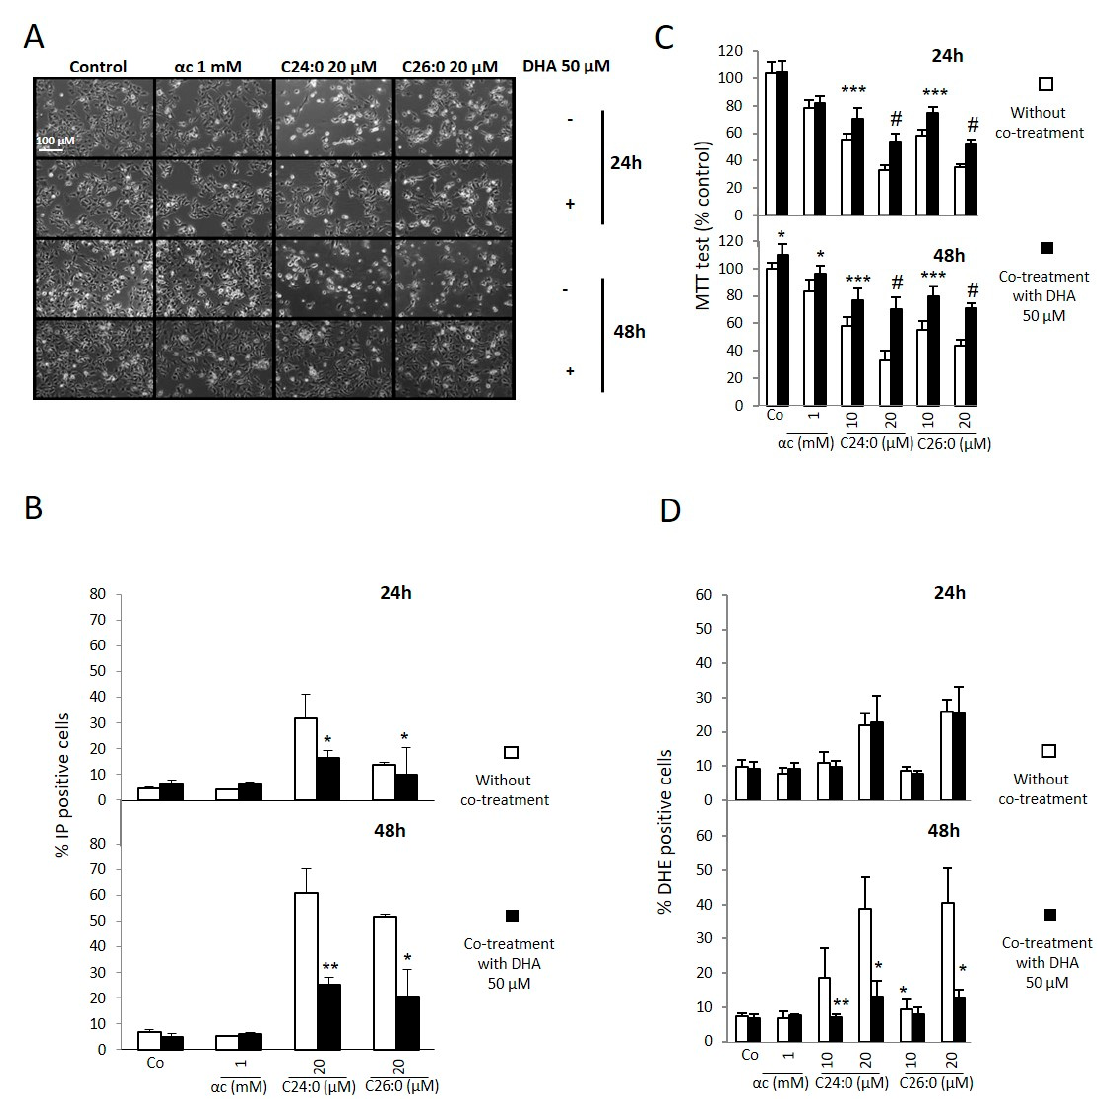
Figure 1. E ff ects of docosahexaenoic acid (DHA) on very long-chain fatty acids (VLCFA) (C24:0 and C26:0) toxicity in 158N murine oligodendrocytes. Murine oligodendrocytes were cultured with C24:0 or C26:0 at 10 or 20 µ M in the presence or absence of DHA at 50 µ M for 24 and 48 h. ( A ): The e ff ect on cell growth, cell adhesion, and cell detachment was determined by phase contrast microscopy. ( B ): the e ff ects of VLCFA and / or DHA on membrane integrity were studied by flow cytometry after staining with propidium iodide. ( C ): the e ff ects of VLCFA and / or DHA on mitochondrial metabolism were evaluated with the MTT assay. ( D ): e ff ects of DHA on the intracellular production of reactive oxygen species (ROS) (including superoxide anion (O 2 − )) induced by VLCFA at 24 and 48 h; evaluation by flow cytometry after staining with dihydroethidium (DHE). Statistical analysis with Mann-Whitney test: * p < 0.05; ** p < 0.01, *** p < 0.001, and # p < 0.0001.